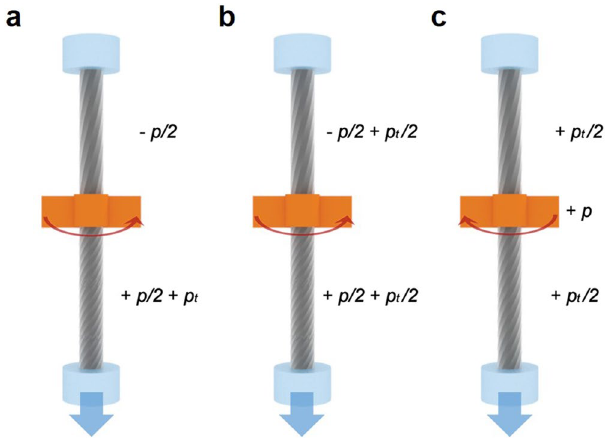
Figure 9. Schematic diagram explaining the rotational behavior of the two-ended tethered CNT yarn. ( a ) The applied untwisting operation under tension leads to additional twisting ( p t ). ( b ) Half of the additional twist is transferred to the upper part for torsional equilibrium. ( c ) Subsequent retwisting removes the additional twist after the untwisting and retwisting operations. This additional twist is called tension-induced twist.